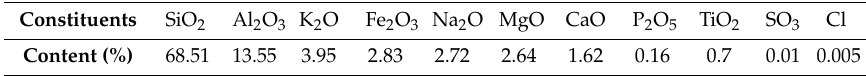
Table 1. Chemical constitution of used sand.